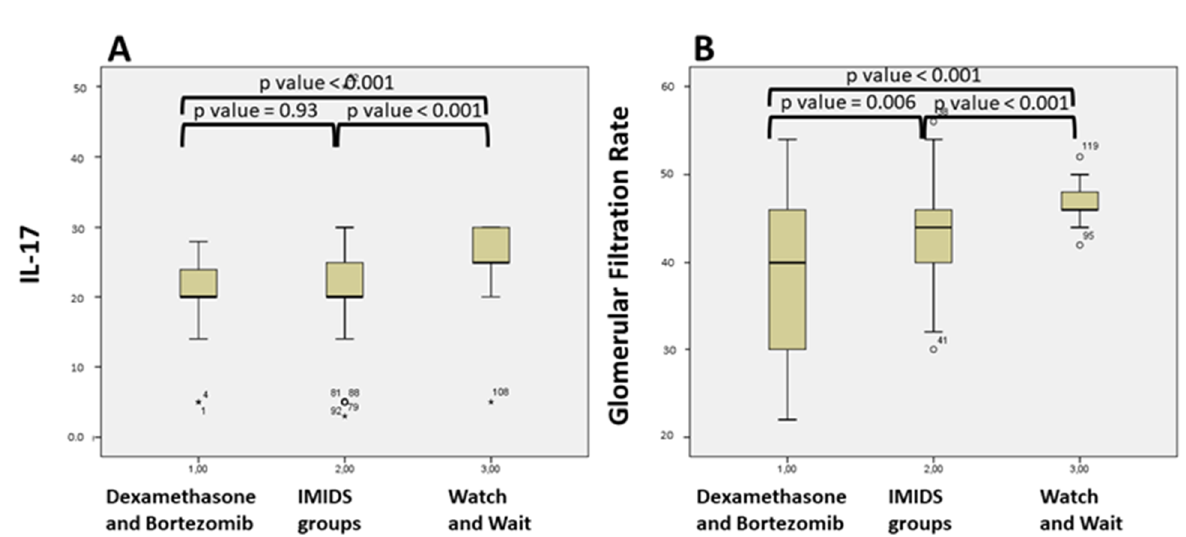
Figure 3. Comparison of patients based on different treatment: ( A ) IL-17 levels in Dexamethasone and Bortezomib; IMiDs based treatment; Watch and Wait Smoldering MM patients; ( B ) Glomerular Filtration Rate levels in Dexamethasone and Bortezomib; IMiDs based treatment; Watch and Wait Smoldering MM patients ( C ) Microvesicles in Dexamethasone and Bortezomib; IMiDs based treatment; Watch and Wait Smoldering MM patients ( D ) TGF-β in Dexamethasone and Bortezomib; IMiDs based treatment; Watch and Wait Smoldering MM patients. Intragroup IMiDs homogeneity was confirmed with no statistical difference in all the variables tested other than the older age in the MPT group versus Lenalidomide, respectively, 82 (77–82) vs. 74 (72–80) p = 0.005. 4. Discussion To the best of our knowledge, this is the first report correlating circulating MVs and cytokines to thrombotic complications in MM patients treated with a specific therapy. Two studies proposed that hypercoagulability in MM arises from thrombin generation due to clotting activation via TF and phospholipids activity [16,17]. Our result is in agreement with Auwerda et al., who detailed, that in a MM cohort under chemotherapy, elevated MV-TF activity in patients who developed VTE, in contrast to patients who do not develop VTE [17]. This elevated MV-TF activity may be associated with increased MVs, especially during anti-myeloma treatment. Importantly, our study